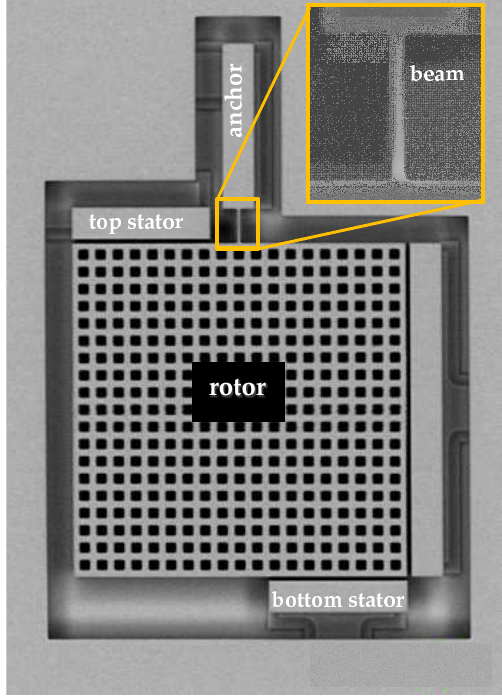
Figure 1. SEM picture of the on-chip testing